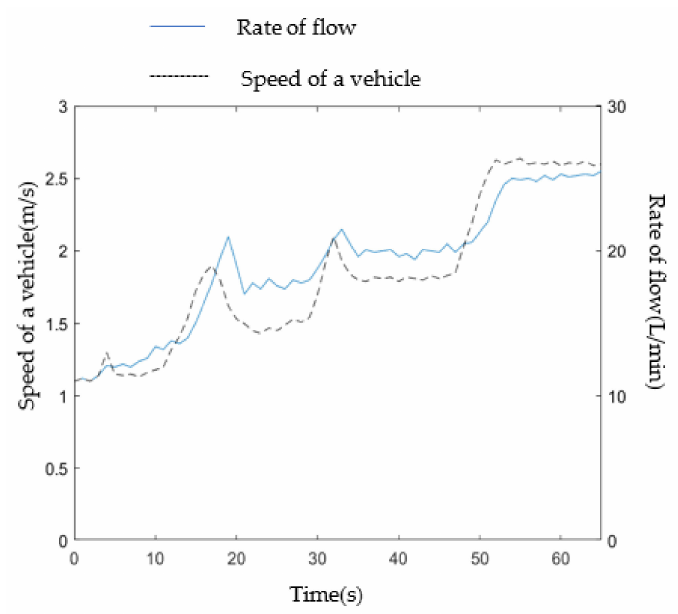
Figure 20. Test results of liquid manure flow by GA–BPNN–PID